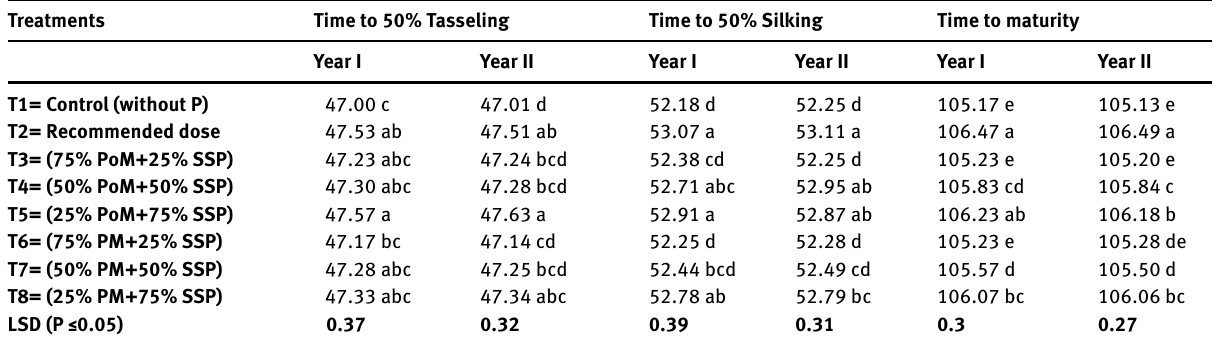
Table 3: Effect of integrated phosphorus management through organic manures and inorganic fertilizer on maize phenology (Days) Treatments